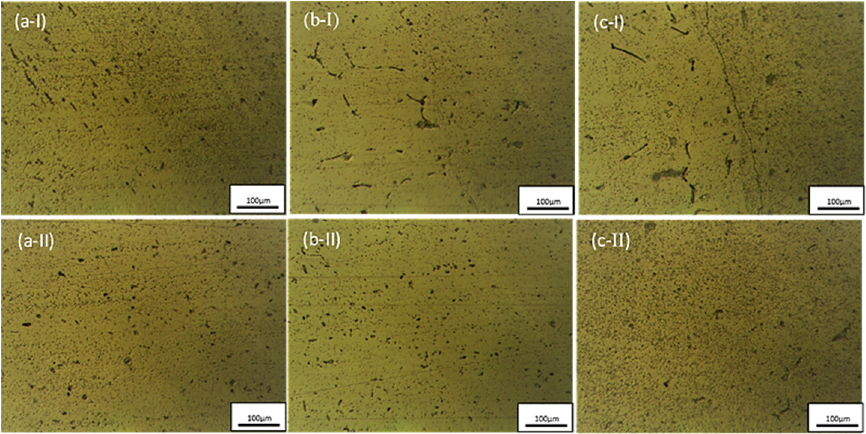
Figure 20. Microstructure of FSPed surface using TTH tool at 1200 rpm for feed rates of, ( a ) 20 mm/min, ( b ) 25 mm/min, and ( c ) 30 mm/min of different regions, whereby (a-I–c-I) is HAZ-SZ boundary and (a-II–c-II) is the SZ.